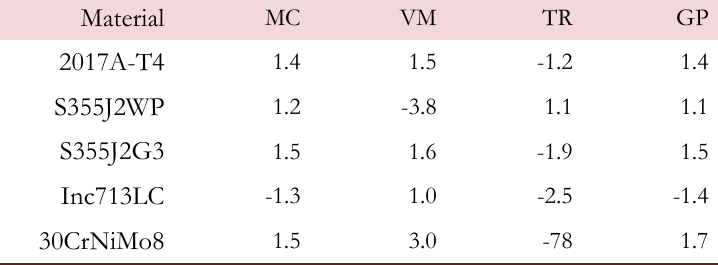
Table 3: Average band